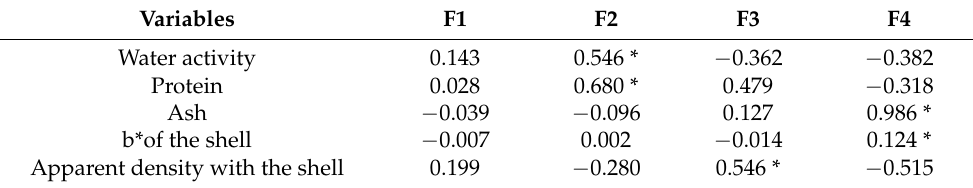
Table 9. Structure matrix accounting only for the five variables included in the